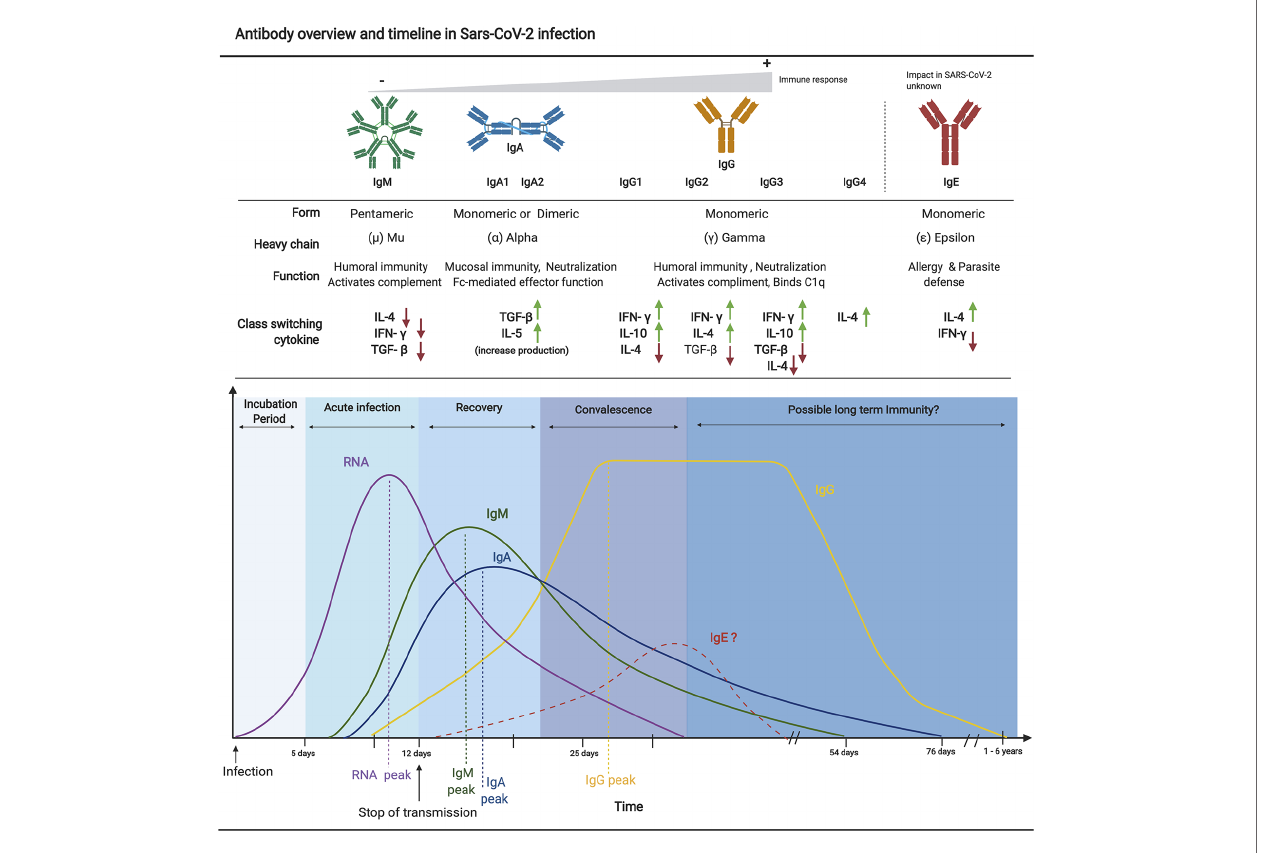
FIGURE 1 | Overview of antibody isotype characteristics and an approximate timeline from SARS-CoV-2 infection to possible immunity. Each antibody isotype is represented with their typical form and associated heavy chain. A brief description of their main function as well as a representation of upregulated and downregulated cytokine necessary for each class switching is also included. The approximate timeline of appearance and subsequent decrease of each isotype in relation to the viral RNA is shown. The curves and values are based on recent serological studies discussed in this review. Since limited literature is available on the implication of IgE in the pathogenesis and antibody mediated immunity to SARS-CoV-2, as such the representation of the IgE timeline is purely hypothetical. Figures were generated using